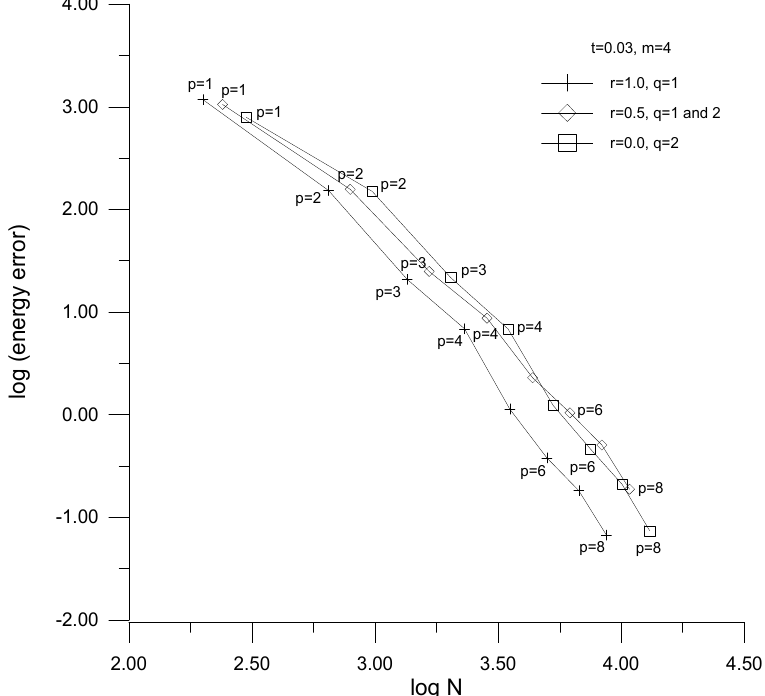
Figure 26. Convergence curves—the membrane shell with the classical transition